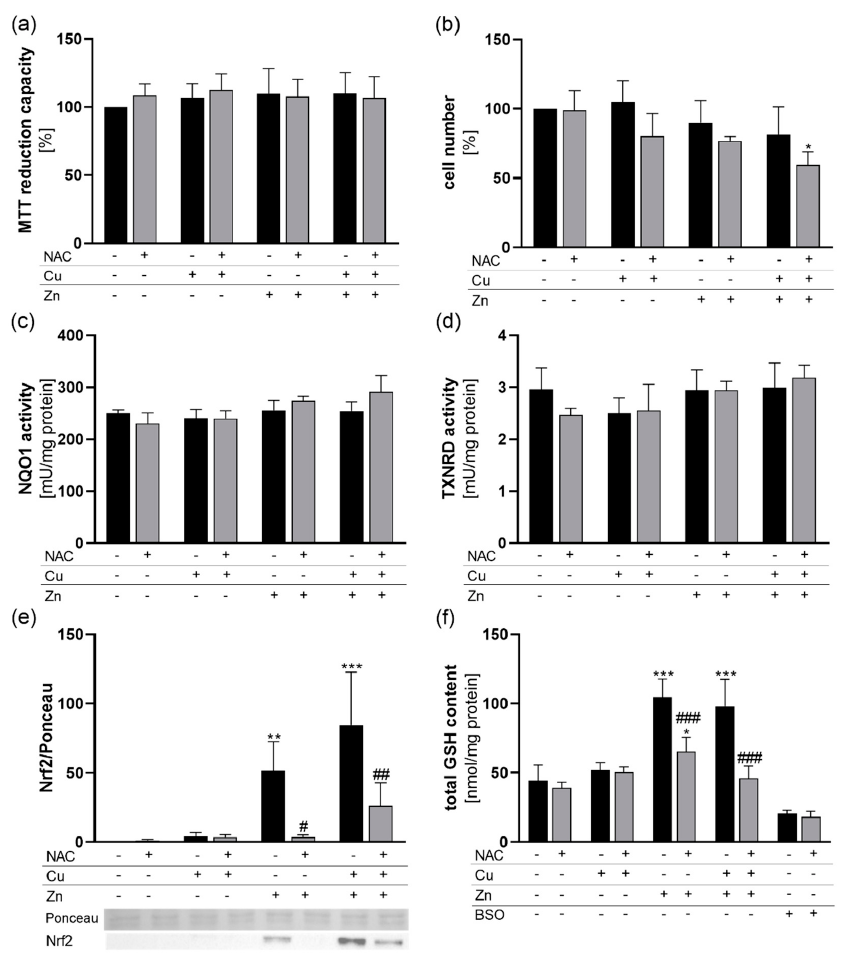
Figure 1. Cell viability and cellular redox homeostasis in response to NAC treatment in combination with Cu and Zn. HepG2 cells were cultured for 6 ( a – d , f ) or 4 h ( e ) with or without 1 mM NAC in combination with 50 µ M CuSO 4 , 50 µ M ZnSO 4 or both. ( a ) MTT reduction capacity and ( b ) cell numbers were analyzed. ( c ) NQO1 and ( d ) TXNRD activities were measured photometrically. ( e ) Nuclear translocation of Nrf2 was analyzed by Western blot and normalized to Ponceau staining. ( f ) The total GSH content of the cells was determined photometrically. The GSH synthesis inhibitor BSO was used as positive control. Results are depicted as mean + SD ( n = 4). Statistical analysis was calculated by two-way ANOVA with Bonferroni´s post-test. * p < 0.05; ** p < 0.01; *** p < 0.001 vs. cells without Zn and Cu treatment (trace element e ff ect); # p < 0.05; ## p < 0.01; ### p < 0.001 vs. − NAC (NAC e ff